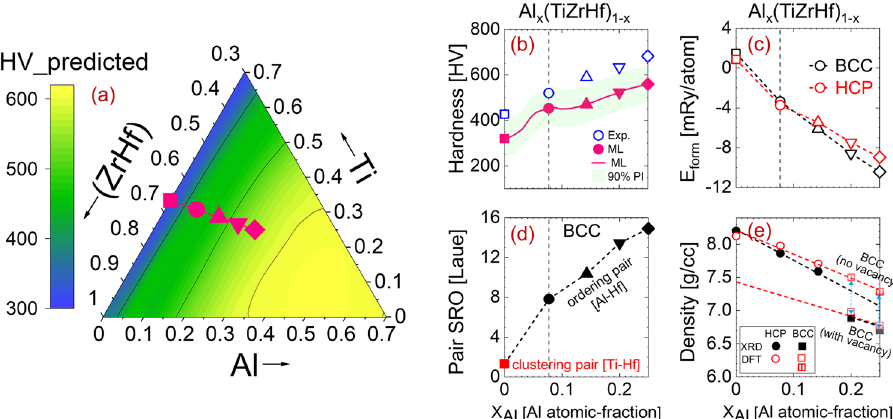
Fig. 5 ML hardness predictions and corresponding DFT-predicted formation enthalpy and SRO. a Predicted hardness contours for Al x Ti y (ZrHf) 1- x - y system. b Experimental and ML-predicted hardness for Al x (TiZrHf) 1- x alloys with a 90% prediction-interval (PI). c DFT energy calculations shows the relative stabilities of the BCC and HCP structures. d DFT SRO pairs show the ordering and clustering tendencies. e DFT and XRD densities compared for the HCP, BCC (vacancy-stabilized) and disordered BCC (without vacancy)